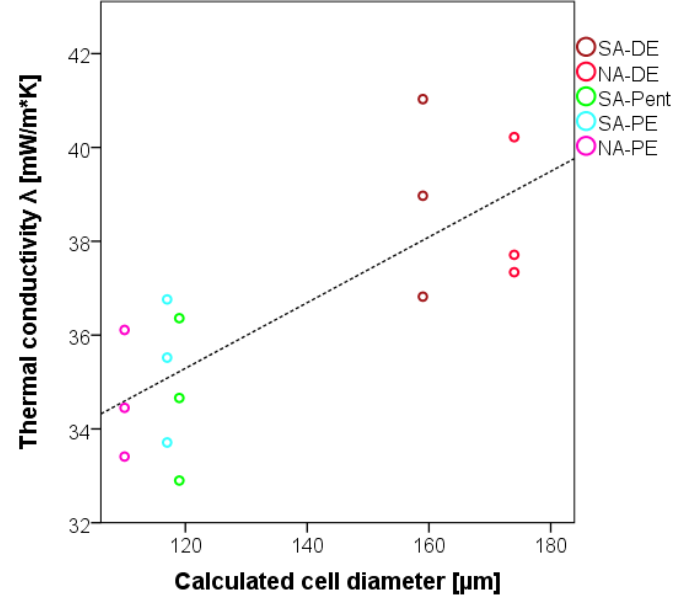
Figure 5. Thermal conductivity of the foams against cell diameter .